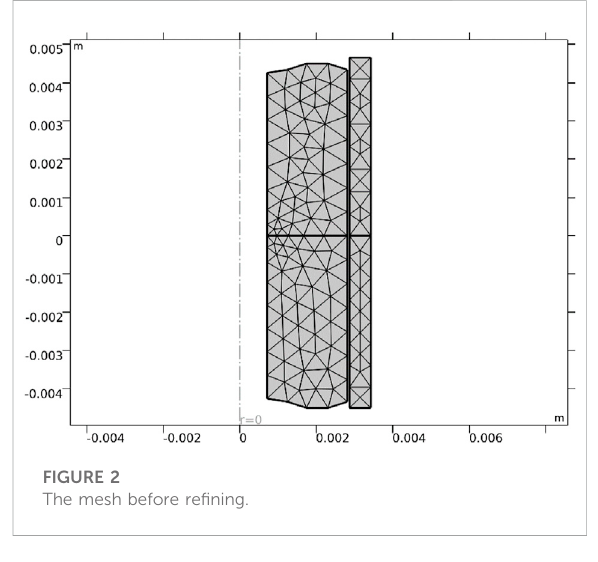
FIGURE 2 The mesh before re fi ning.